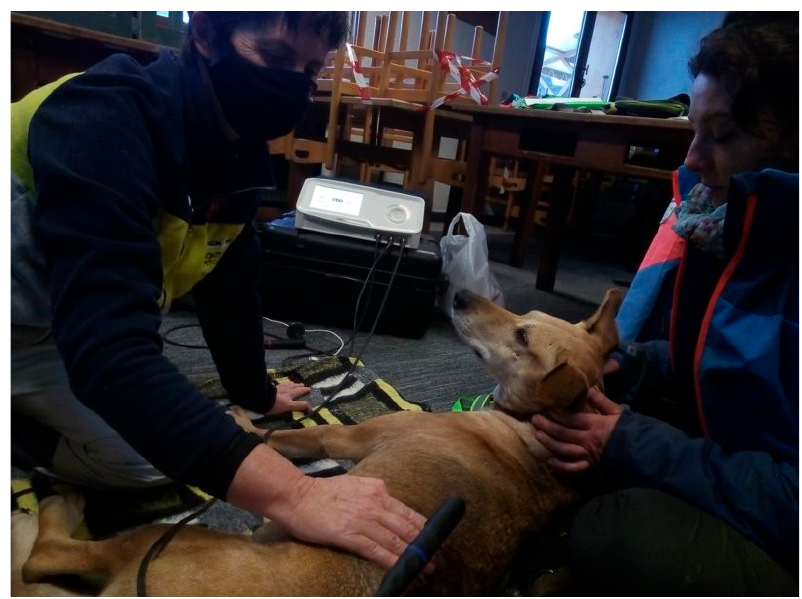
Figure 3. Scenario of a CRet session, where the dog received his treatment comfortably.